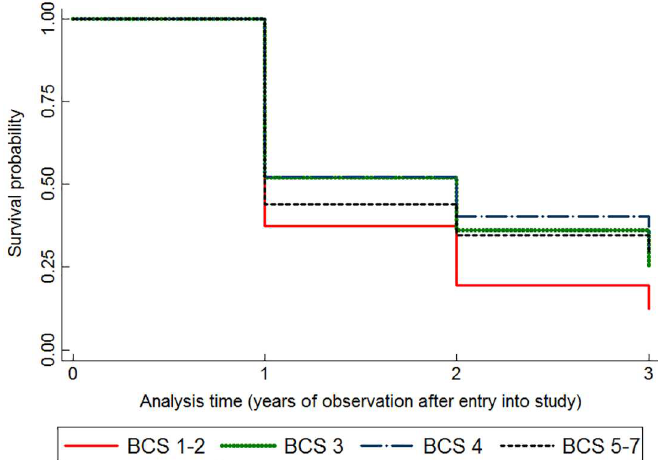
Fig 6. Kaplan-Meier survival estimatesfor survival probabilities of dogs within different body condition scores (BCS). BCS was scored as 1–2 = poor; 5 = ideal; 8–9 = obese. Dogs with BCS 1–2 (solid red line) had significantly lower survival probabilities comparedto all other categoriesregardless of village, age, sex, or